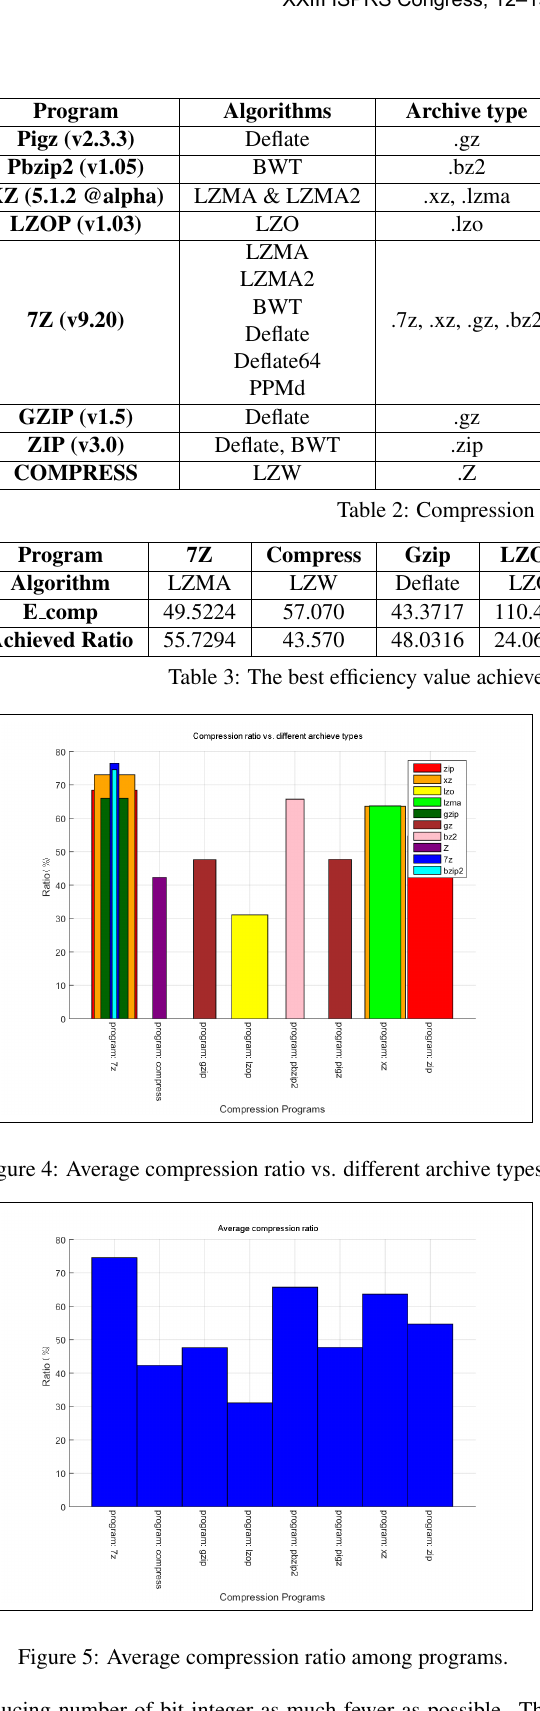
Figure 7: Average compression time vs. applied